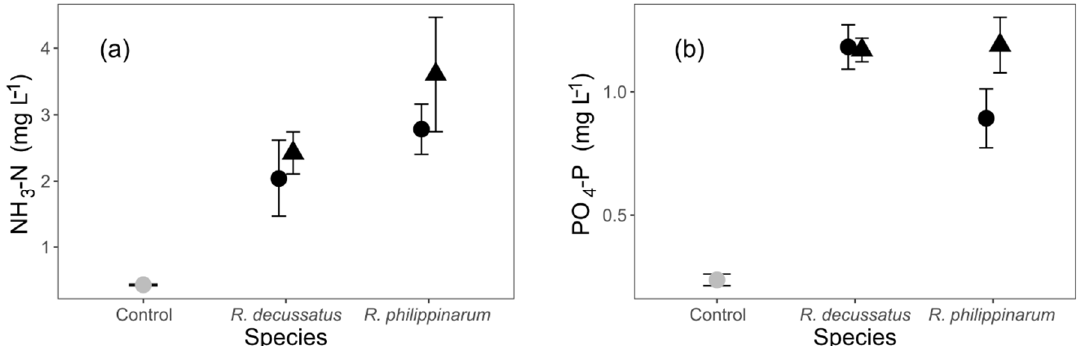
Figure 1. The effects of different temperature treatments on the sediment reworking by Ruditapes decussatus and R. philippinarum (cm, mean ± SE): ( a ) Surface boundary roughness (SBR), ( b ) mean mixed depth of luminophores’ redistribution ( f-SPI L mean ), ( c ) median mixed depth of luminophores’ redistribution ( f-SPI L median ), and ( d ) maximum mixed depth of luminophores’ redistribution ( f-SPI L max ), at day 12. For clarity, jitter has been applied to the × = argument of the plot function to avoid overplotting. For comparison, measurements in the absence of animals are presented (grey, control).